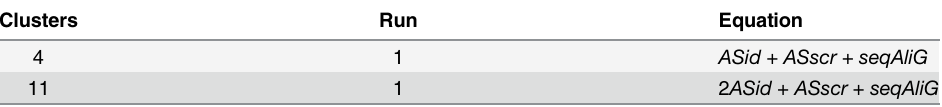
Table 10. Data combinations which yielded the best results for the serine proteases in five runs of the GP system. Clusters Run